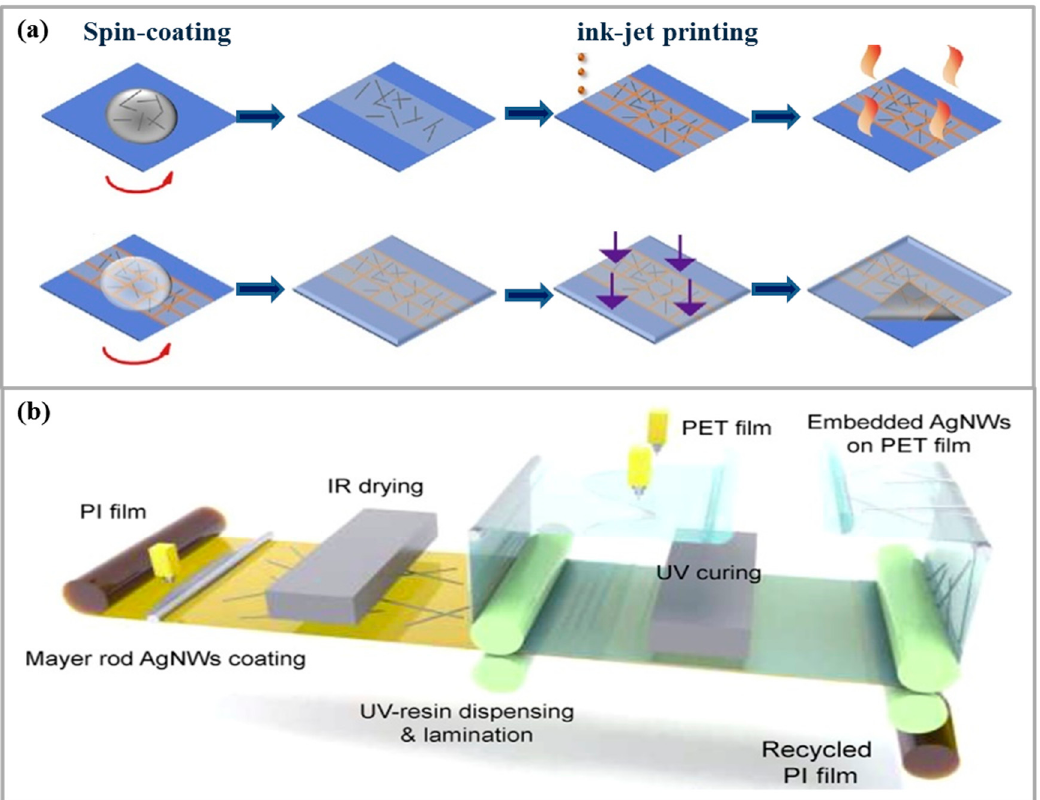
Figure 4. Two preparation methods of Ag NWs TCE. ( a ) Fabrication processes of the hybrid electrode on a photopolymer substrate [98]. Copyright 2017, Organic Electronics. ( b ) Schematic illustration of the RTR fabrication process for the embedded Ag NWs TCE on PET film [102]. Copyright 2017, Organic